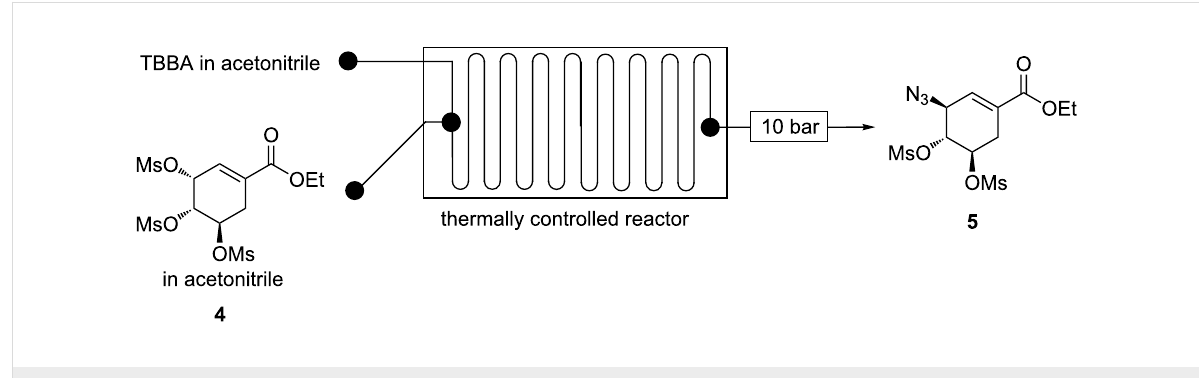
Figure 13: Continuous-flow system for C-3 azidation of mesyl shikimate using TBAA.